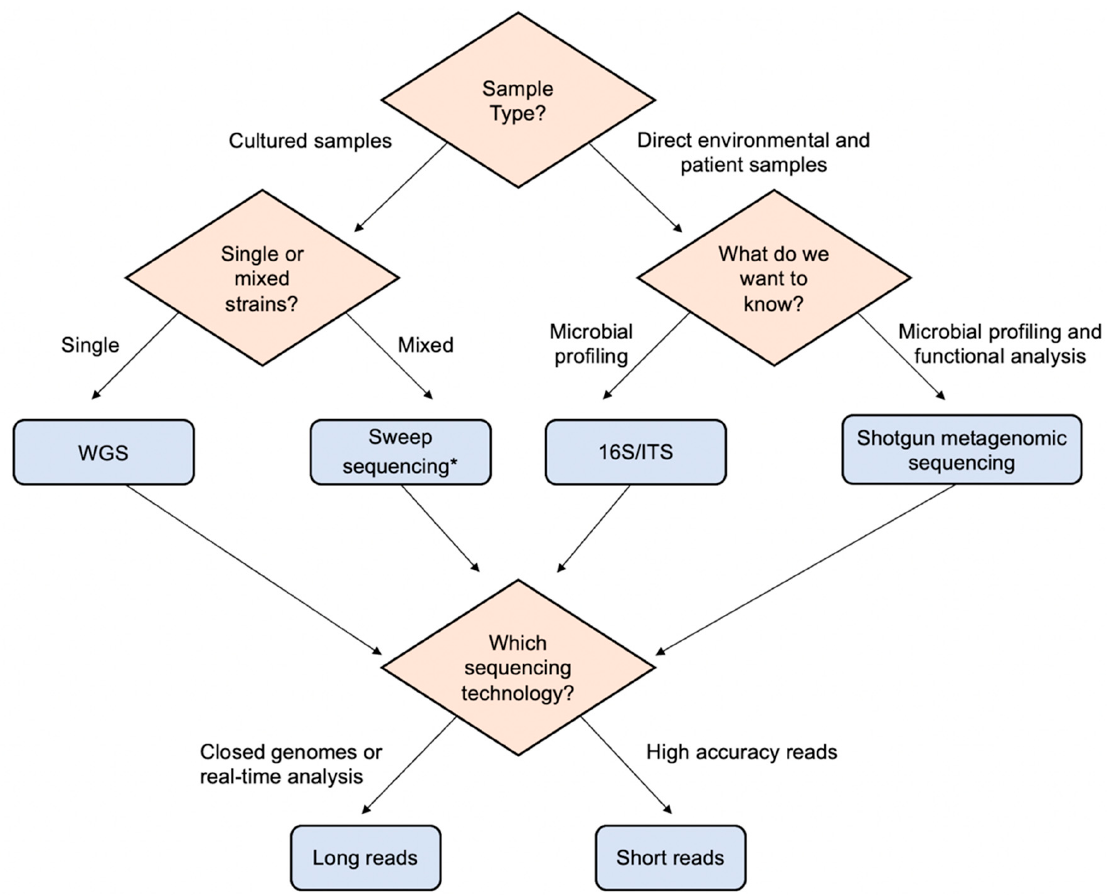
Figure 1. Decision tree for the selection of sequencing technology. The type of samples and research questions guide the selection of suitable sequencing strategies and sequencing platforms. The diamonds represent the checkpoints/questions, and the blue rectangles represent the sequencing strategies. * Sweep sequencing is a technique in which concurrent sequencing of multiple colonies at the same time is possible—this could also be considered a metagenomic approach.